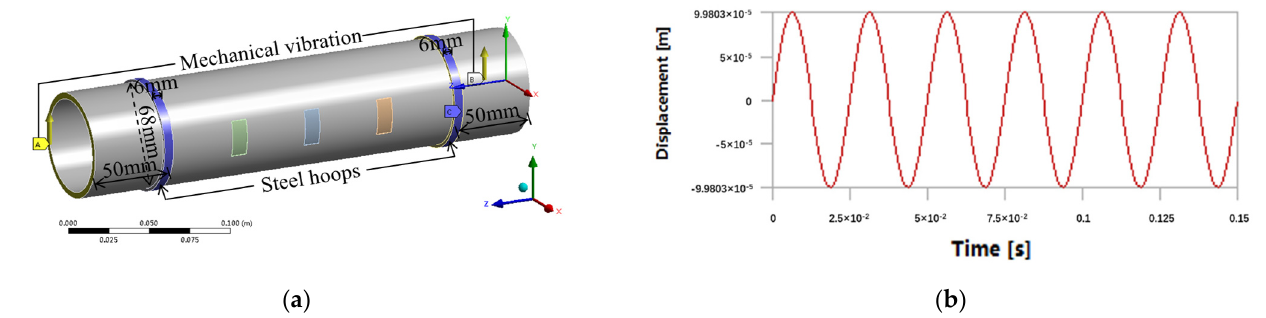
Figure 10. Diagram of ( a ) mechanical vibration; ( b ) sinusoidal vibration. Table 7. Correlation coefficient.